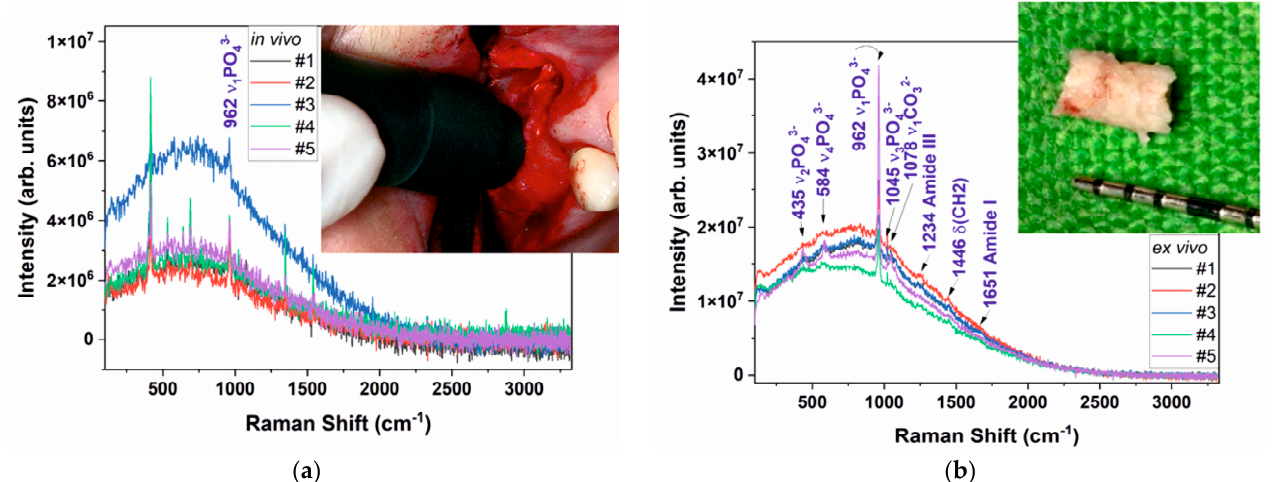
Figure 1. Raman spectra in 100–3300 cm − 1 range acquired in vivo ( a ) and ex vivo ( b ) for all patients. The insets are showing the Raman probe head during in vivo acquisition ( a ) and bone sample collected from patient #3 for ex vivo investigation.